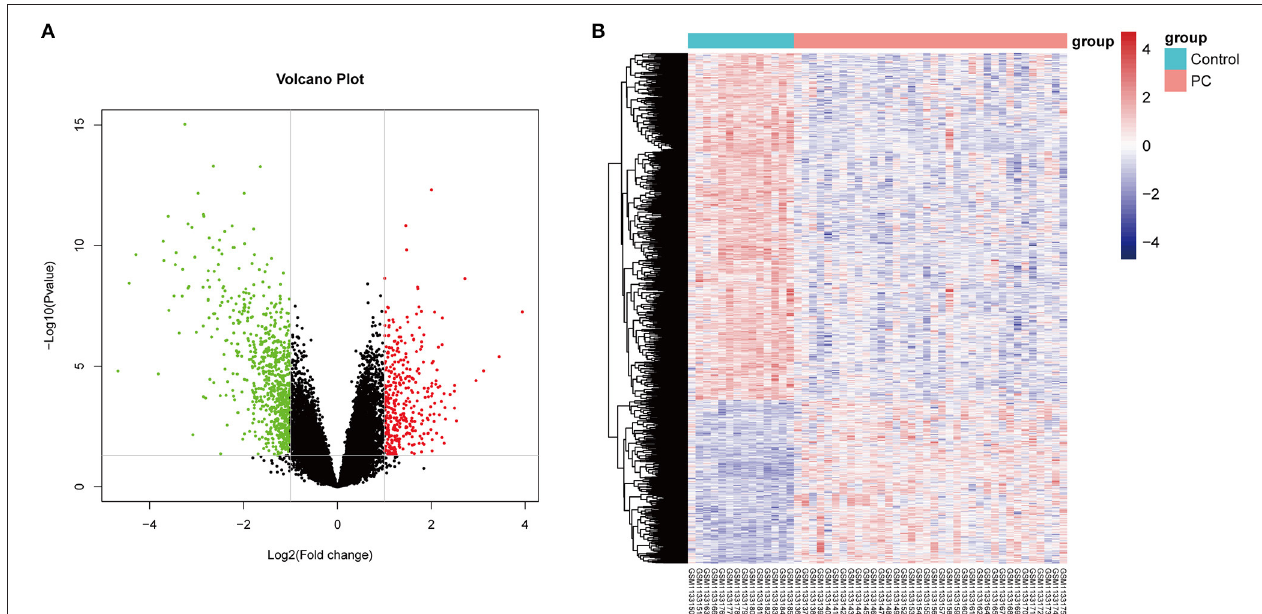
FIGURE 1 | The differentially expressed genes (DEGs) in prostate cancer. (A) The Volcano plot shows the differentially expressed genes in the dataset GSE46602. The red color indicates the upregulated genes in prostate cancer, and the green color indicates the downregulated genes in prostate cancer. (B) The heat map shows the DEGs between prostate cancer tissue and normal